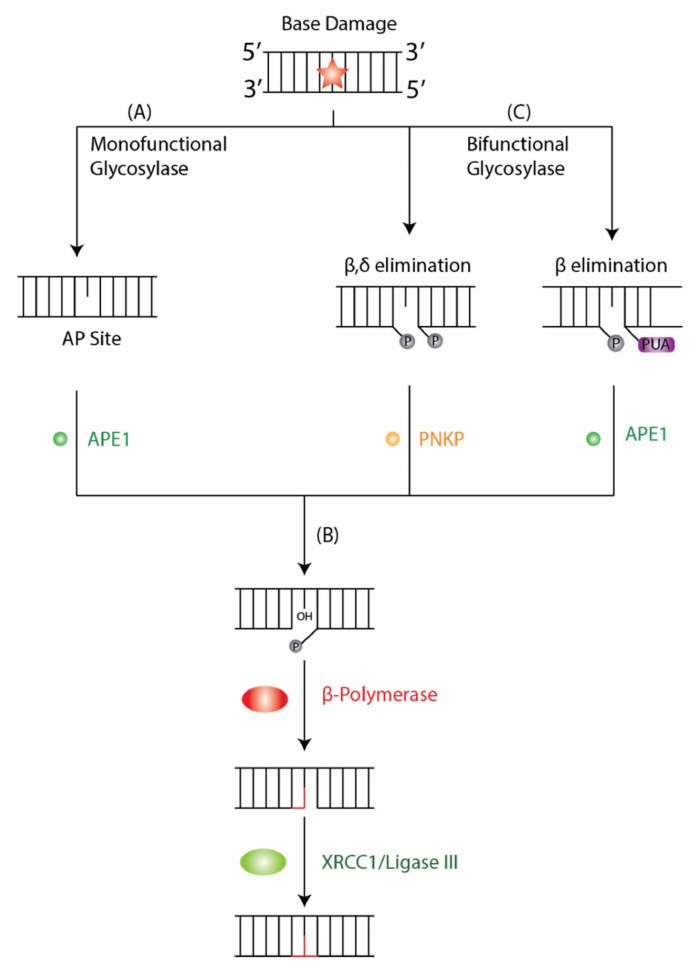
Figure 1. Schematic Representation of BER Pathway. BER is initiated by DNA Glycosylases that recognize and bind to a base lesion. ( A ) Monofunctional Glycosylases will identify the DNA lesion and catalyze the hydrolysis of the N-glycosyl bond that releases the damaged base and generates an AP site that is processed by APE1. ( B ) A bifunctional glycosylase will recognize and remove oxidative lesions either through β , δ or β -elimination to create a single strand break. The 3 (cid:48) α , β -unsaturated aldehyde and 5 (cid:48) phosphate are further processed by PNKP and APE1, respectively. ( C ) Subsequently, Pol β and XRCC1/Ligase III fill and seal the single nucleotide gap and restore the original base sequence. The orange star denotes base